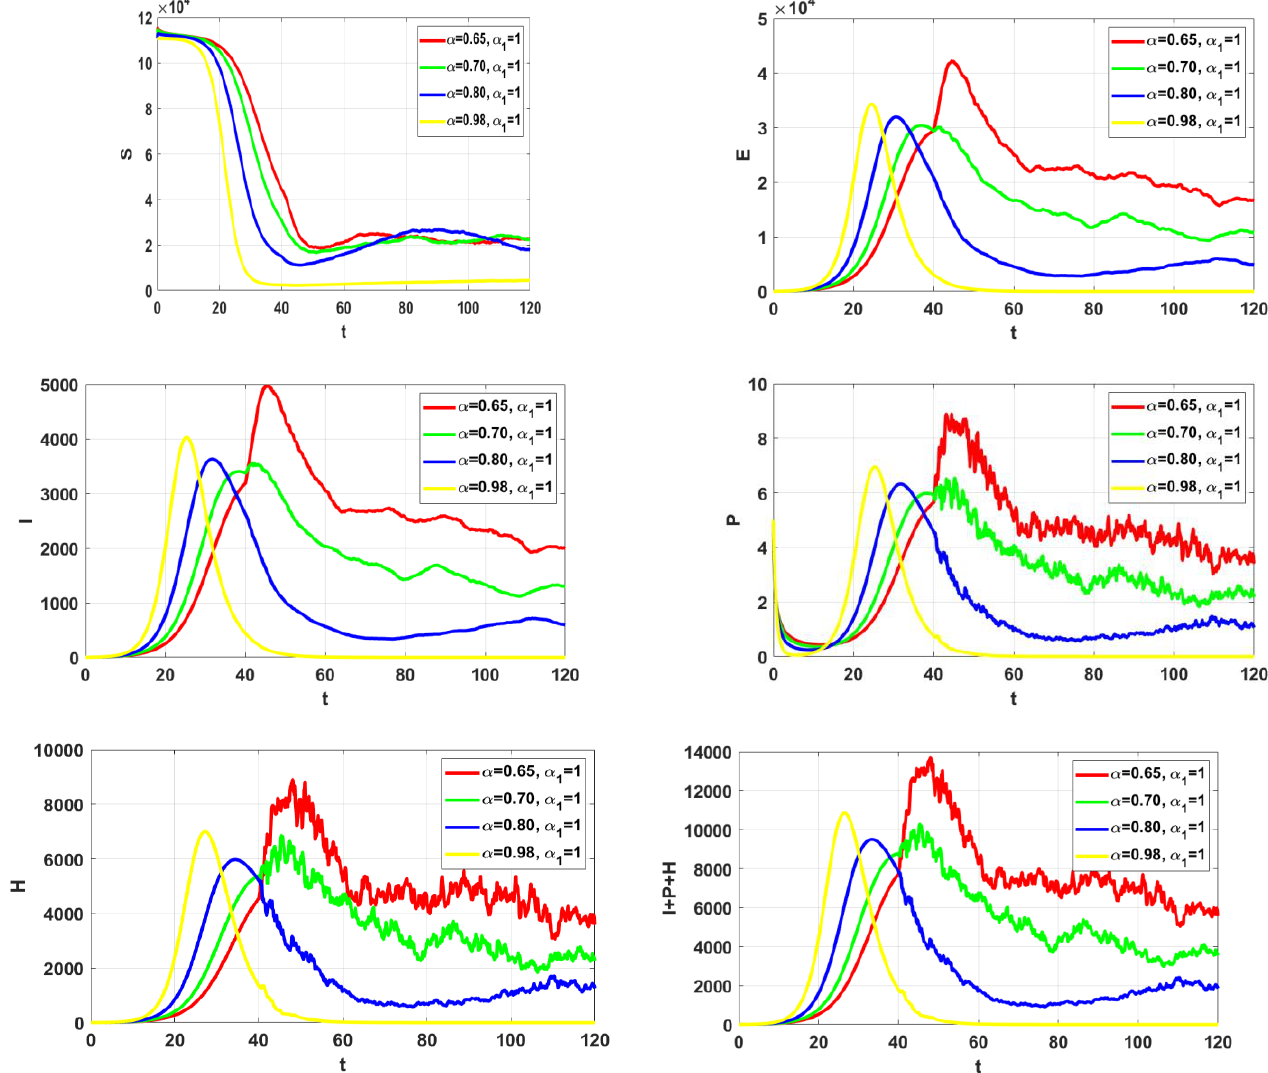
Figure 8. Numerical simulation for system (14–16) at H ∗ = 0.95, α 1 = 1 and different α , σ 1 = σ 2 = σ 3 = 0.01, σ 3 = σ 4 = σ 5 = σ 6 = 0.1.